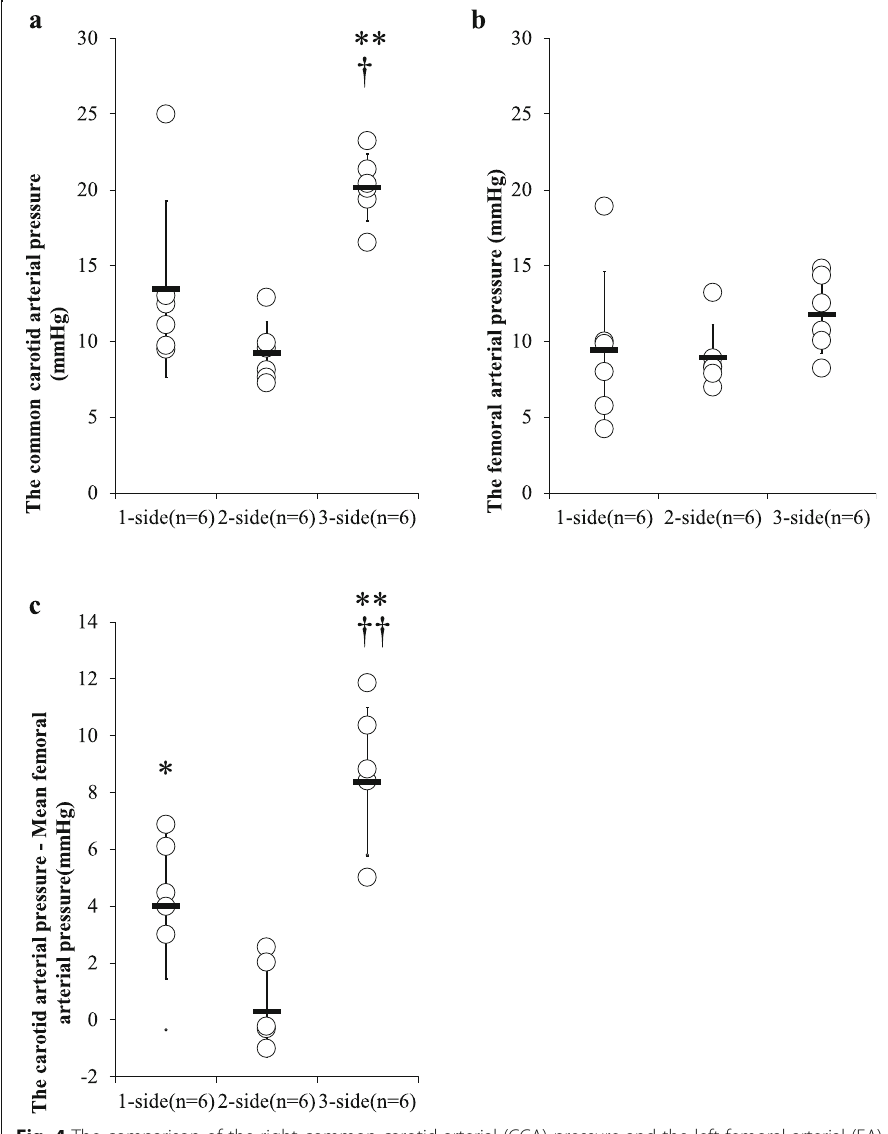
Fig. 4 The comparison of the right common carotid arterial (CCA) pressure and the left femoral arterial (FA) pressures at the same time during chest compression. a This figure shows the CCA pressure. The results are shown as mean ± SD. † P < 0.05 compared with 1-side group. ** P < 0.01 compared with the 2-side group. b The FA pressure. The results are shown as mean ± SD. c The CCA pressure minus FA pressure at the same time. The results are shown as mean ± SD. * P < 0.05 compared with the 2-side group. ** P < 0.01 compared with the 2-side group. †† P < 0.01 compared with the 1-side